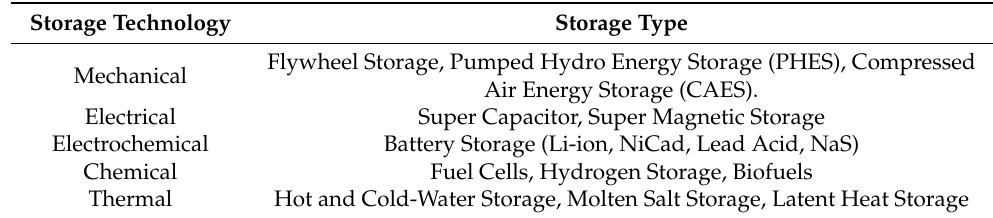
Table 1. Types of storage used in multi-energy EV charging systems.